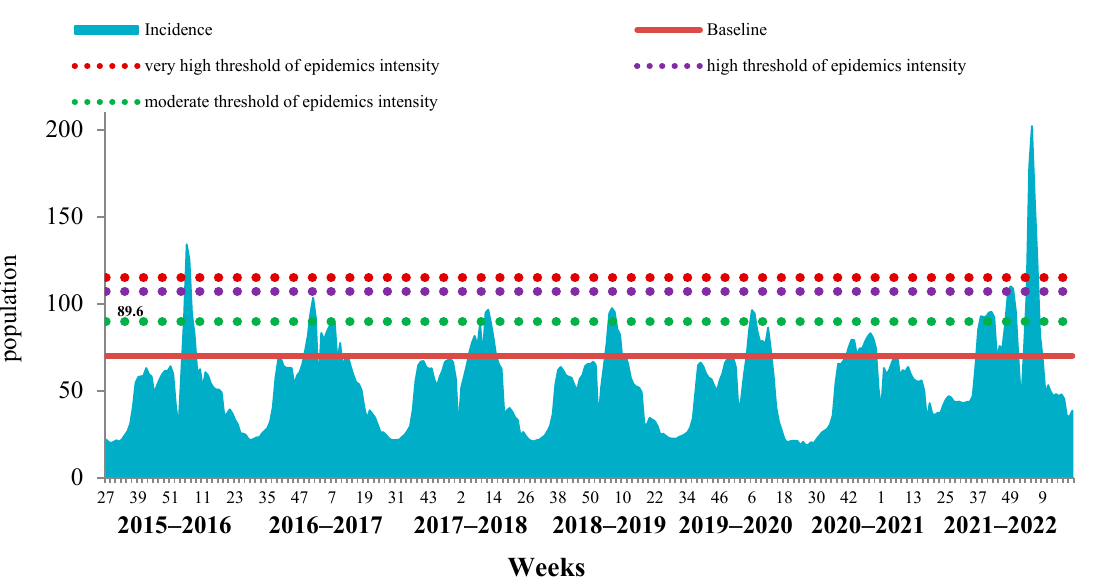
Figure 2. Dynamics of influenza and ARI cumulative incidence in the Russian Federation over the 7 ‐ year period.